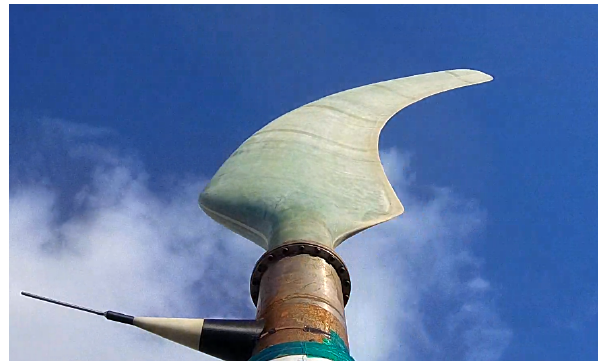
Figure 8. The tip as seen from the boom-mounted